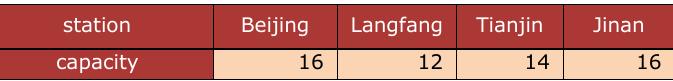
Table 6. Section capacity